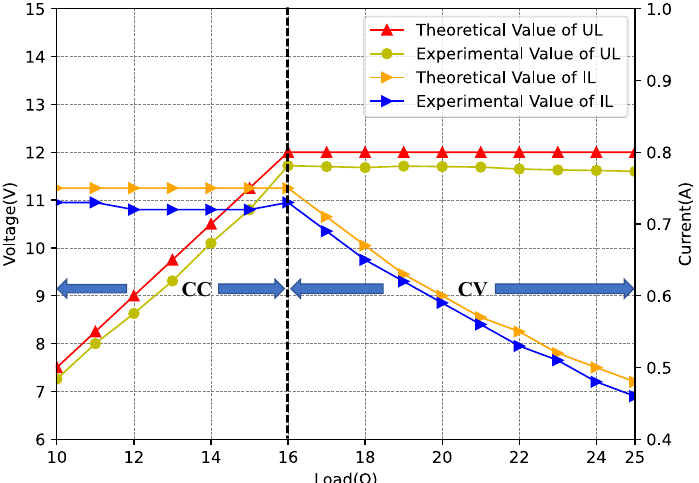
Figure 17. Comparison between experimental results and theoretical values of CC-CV output based on coupling-coefficient estimation.